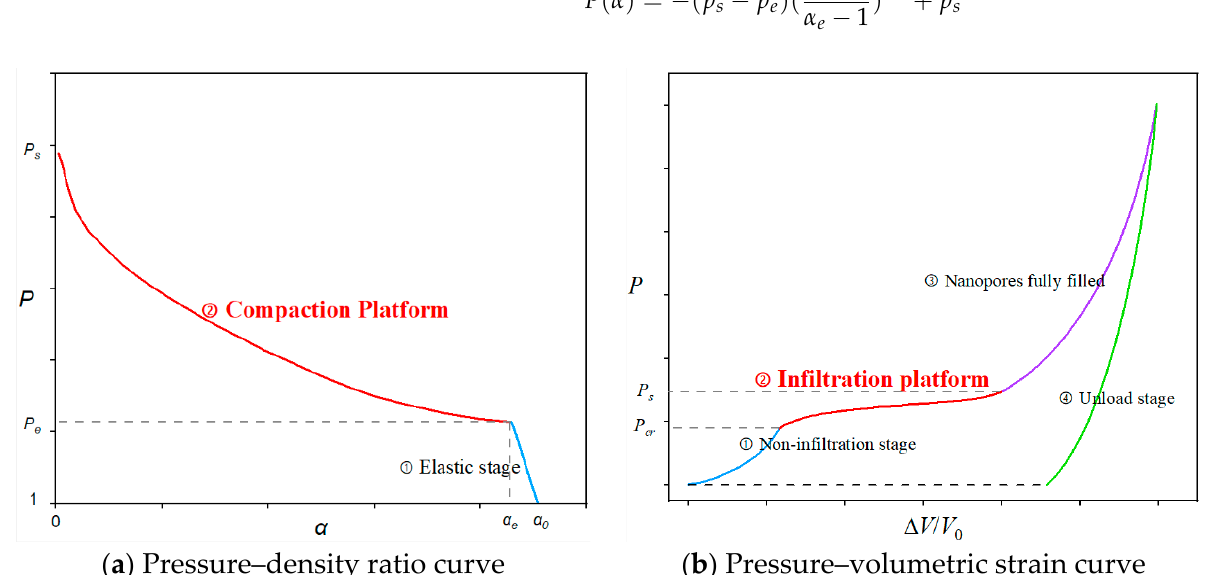
Figure 7. Mapping of nanofluidic system and porous media. Table 1. Parameter settings of Fluka 100-C 8 silicone gel nanofluidic system.